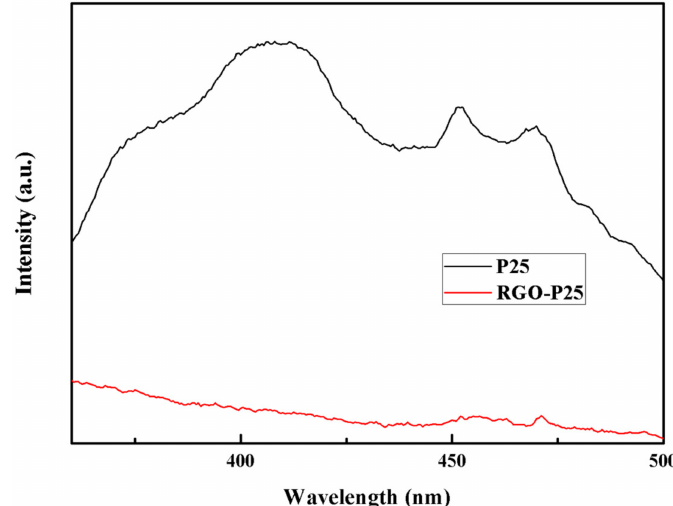
Figure 7. Photoluminescence emission spectra of P25 and RGO-P25